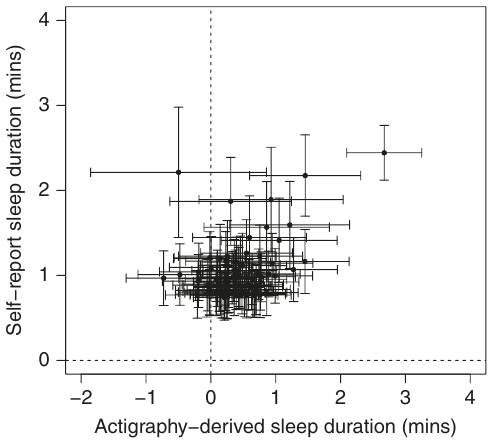
Fig. 3 Comparison of effect estimates for SNPs associated with self- reported sleep duration. The effect estimates for 78 genetic variants associated with self-report sleep duration in a parallel GWAS effort 14 are plotted against the effect estimates on accelerometer-derived estimates of sleep duration. Error bars represent the 95% con fi dence intervals for each effect estimate